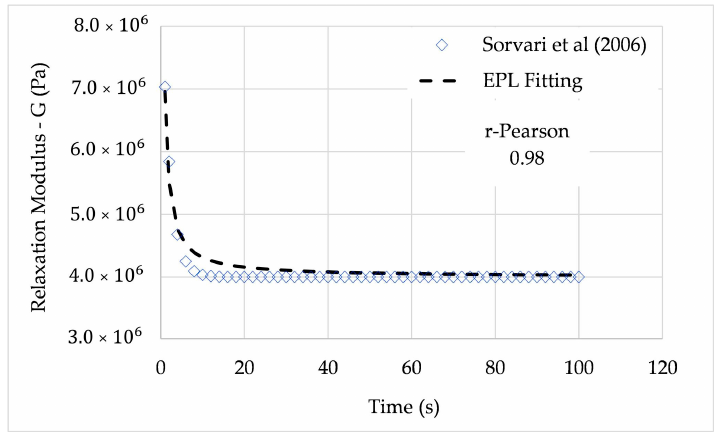
Figure 7. Relaxation modulus from Sorvari et al. (2006) and EPL fitted curve (𝜆 = 2 𝑠 ).